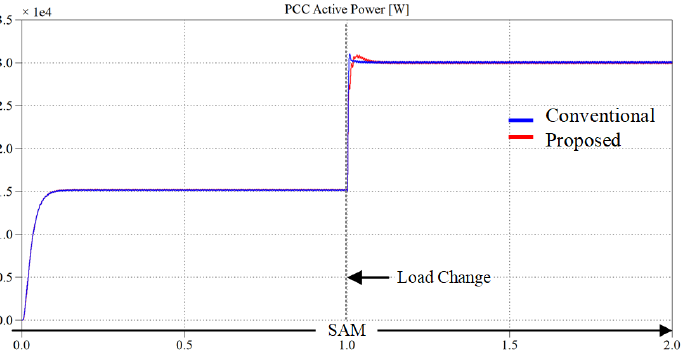
Figure 8. Simulation results of conventional (blue line) and proposed (red line) synchronverter control dynamic under only resistive load condition with load step